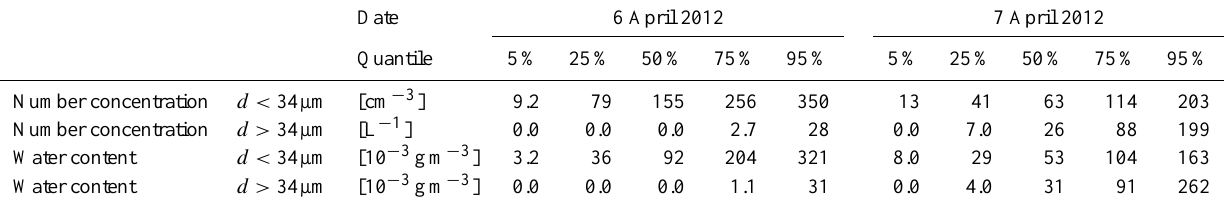
Table 4. Quantiles of cloud property data from the 6–7 April 2012 case using 30s averages divided into two parts (before and after midnight).